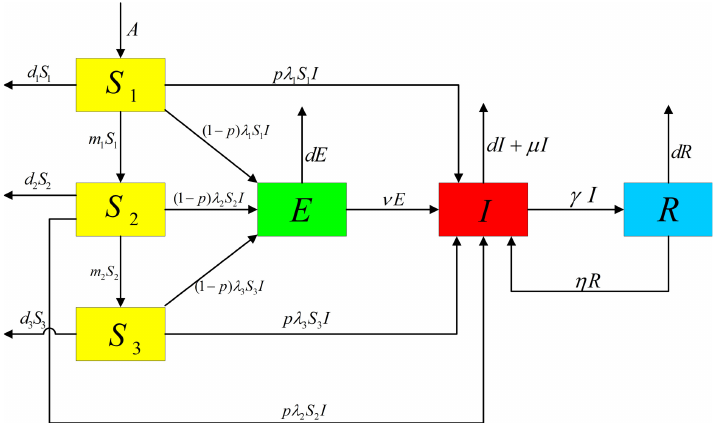
Figure 2. Flow chart of TB transmission with